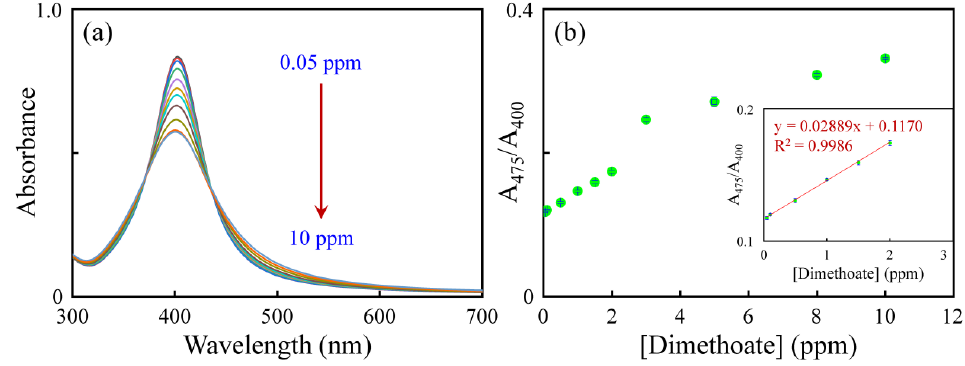
Figure 6. ( a ) UV–vis absorption spectra and ( b ) linear response of the absorption ratio at A 475 /A 400 plotted against the dimethoate concentration ( n = 3). Inset: a linear calibration curve between A 475 /A 400 and the concentration of dimethoate (0.05–2.0 ppm). The calculated LOD of dimethoate was 30 ppb.